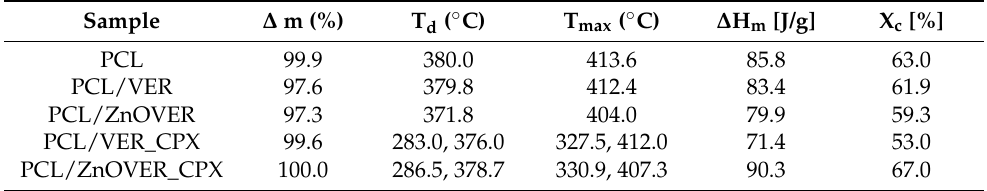
Figure 8. ( a ) TG and ( b ) DTG curves of pure PCL thin film and thin PCL/clay nanocomposite films. Table 3. Thermal data of pure PCL thin film and thin PCL/clay nanocomposite films obtained from TG and DTG curves and crystallinity from DSC.